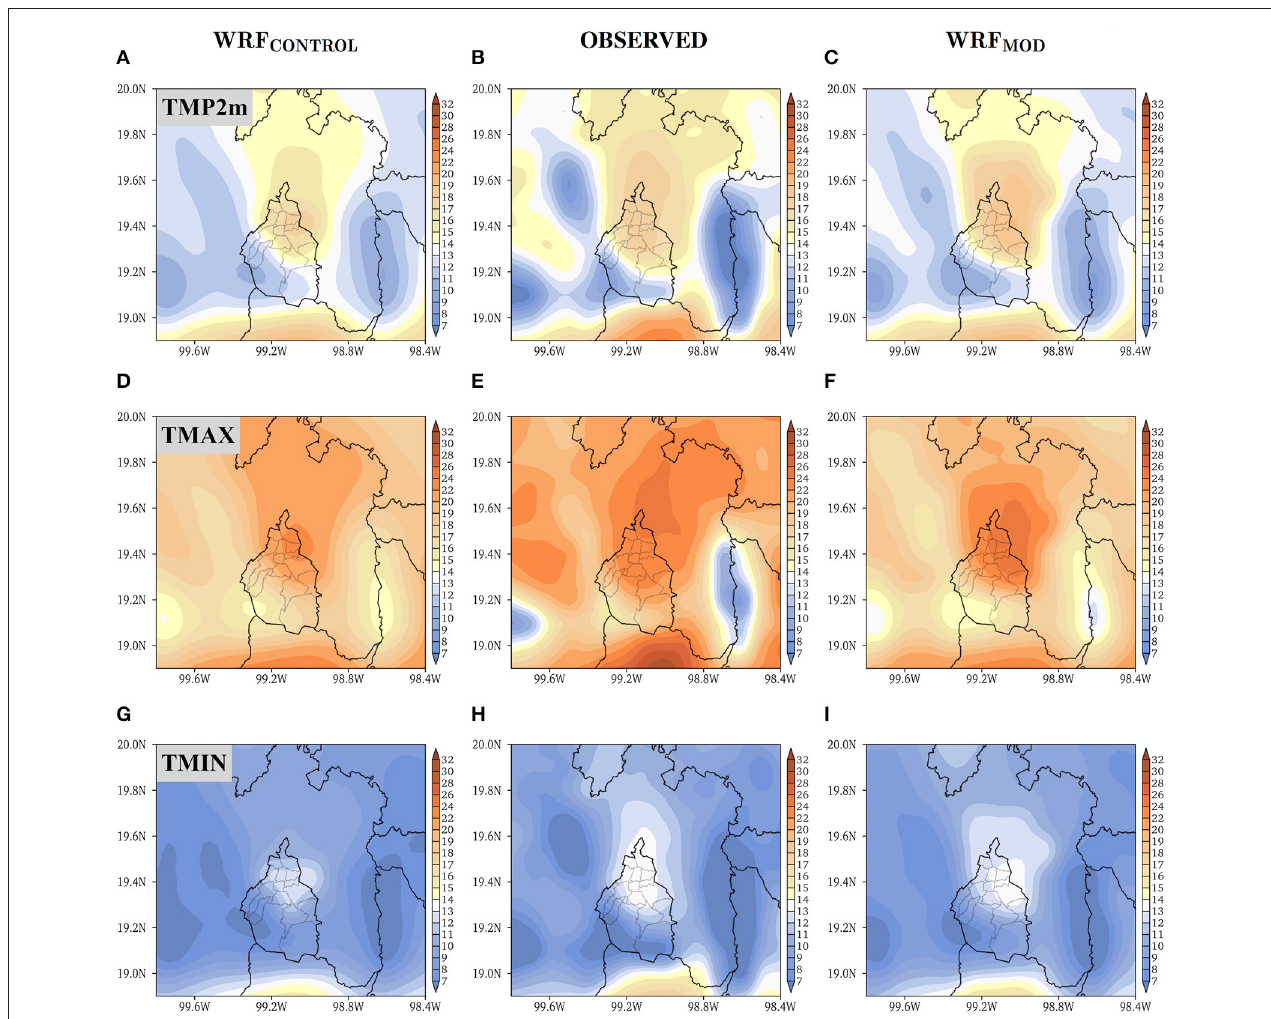
FIGURE 10 | The 2m temperature field ( ◦ C) simulated and observed for July 2014 (A) WRF control experiment (B) OBSERVED, and (C) WRF modified experiment. The maximum temperature field ( ◦ C) simulated and observed for July 2014 (D) WRF control experiment (E) OBSERVED, and (F) WRF modified experiment. The minimum temperature field ( ◦ C) simulated and observed for July 2014 (G) WRF control experiment (H) OBSERVED, and (I) WRF modified